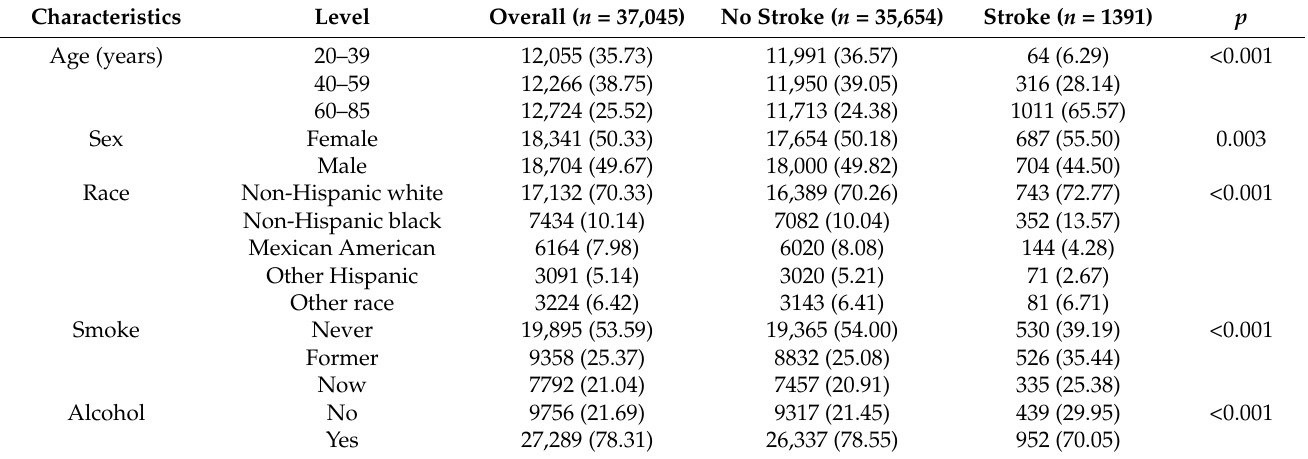
Table 1. Characteristics of the participants between with stroke and without stroke among US